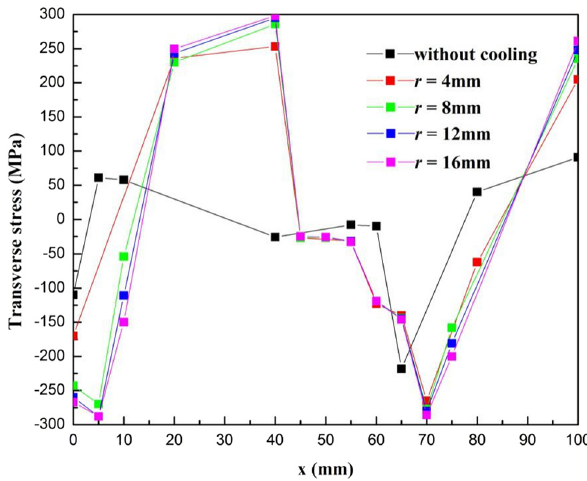
Figure 14: E ff ect of radius of trailing cooling source on the transient von Mises stress.